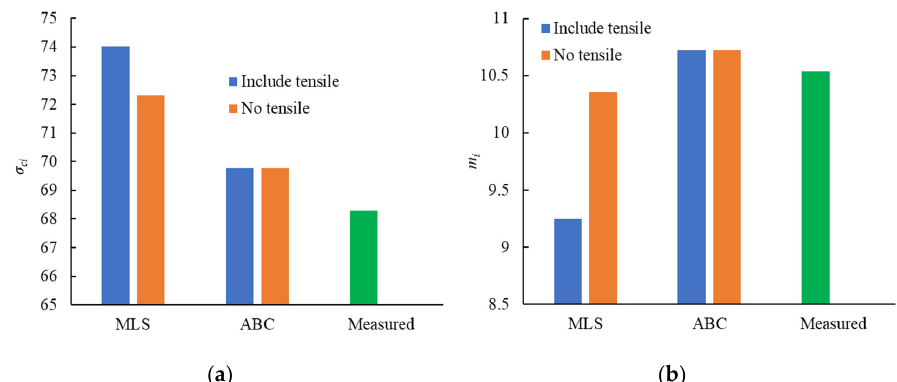
Figure 6. The comparison between the predicted and measured coefficients: ( a ) σ ci ; ( b ) m i .